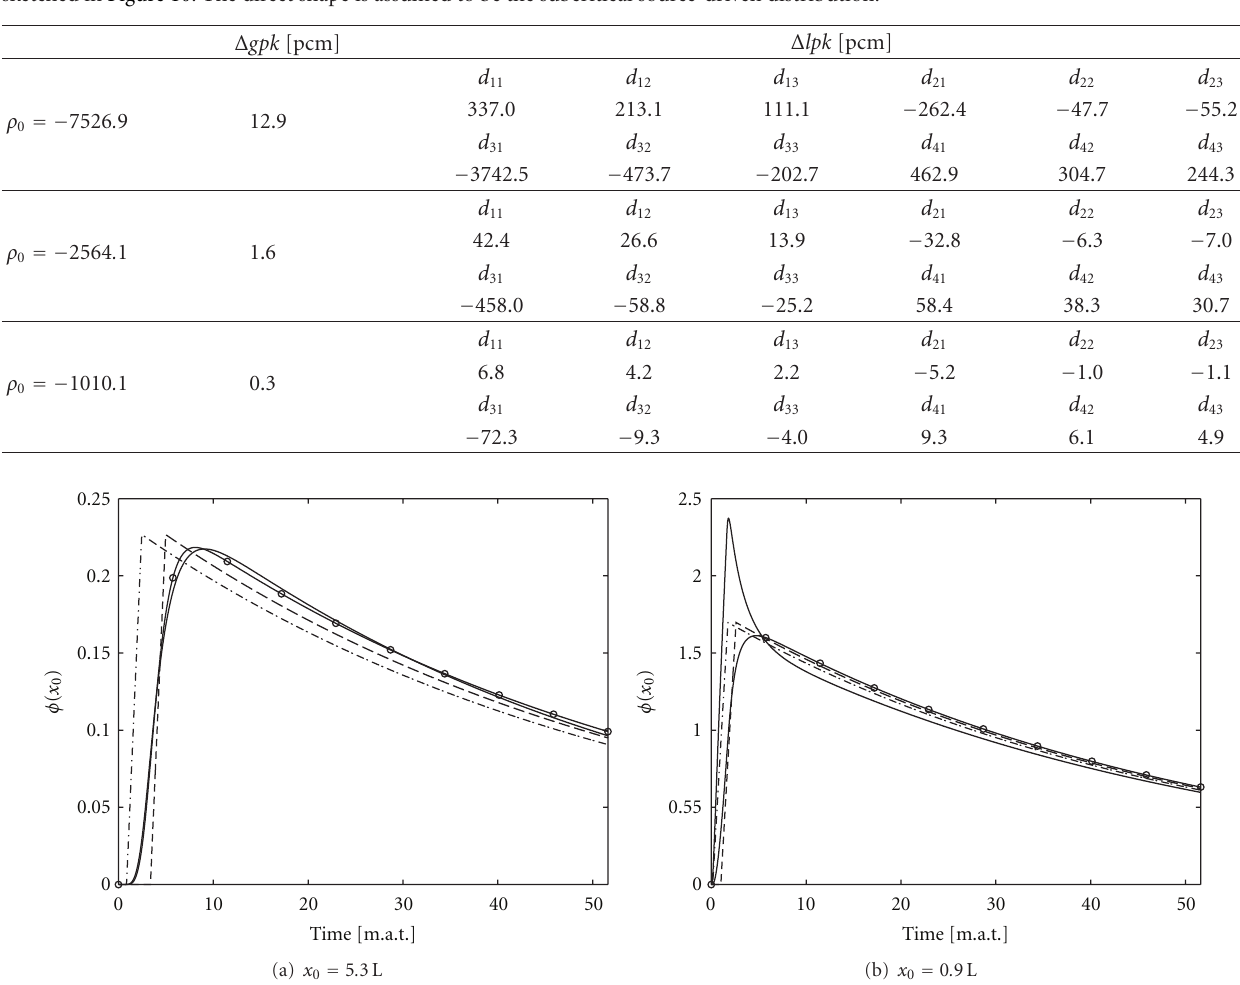
Figure 9: Local flux response to a source pulse obtained with point kinetics in association with a modified treatment of the source time behavior. Solid: reference; dash-dotted: modification 1; dashed: modification 2; circles: modification